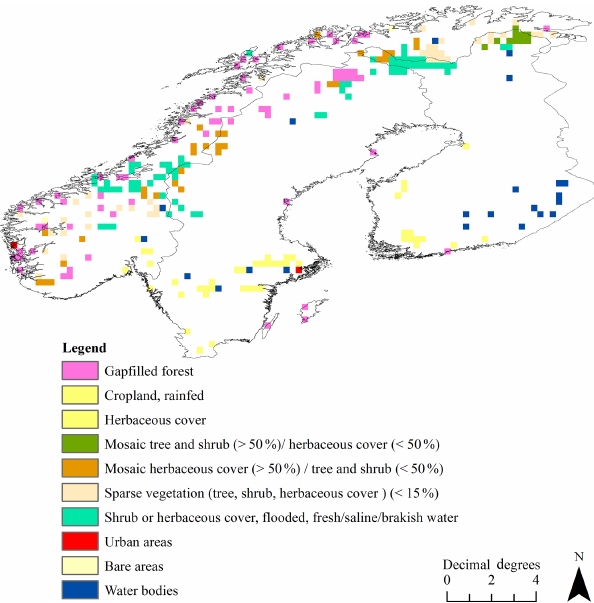
Figure 5. Difference in forest extent between the enhanced back- classified map and the ESA LC product. Both types of data were aggregated to ∼ 0.3 ◦ resolution using mode to display the main differences in the two classifications spatially. The label “Gapfilled forest” is used to indicate areas that were mainly classified as forest by the ESA LC product, but the MS-NFI data indicated non-forest. Other labels (see Fig. 4.) show which main ESA LC classes were classified as forest in the enhanced back-classified map. Note that the confusion matrix between the ESA LC product and enhanced back-classified map was prepared using ∼ 0.003 ◦ resolution (Ta- ble 4), whereas the map resolution shown here is ∼ 0.3 ◦ . For colors, see the online version of the